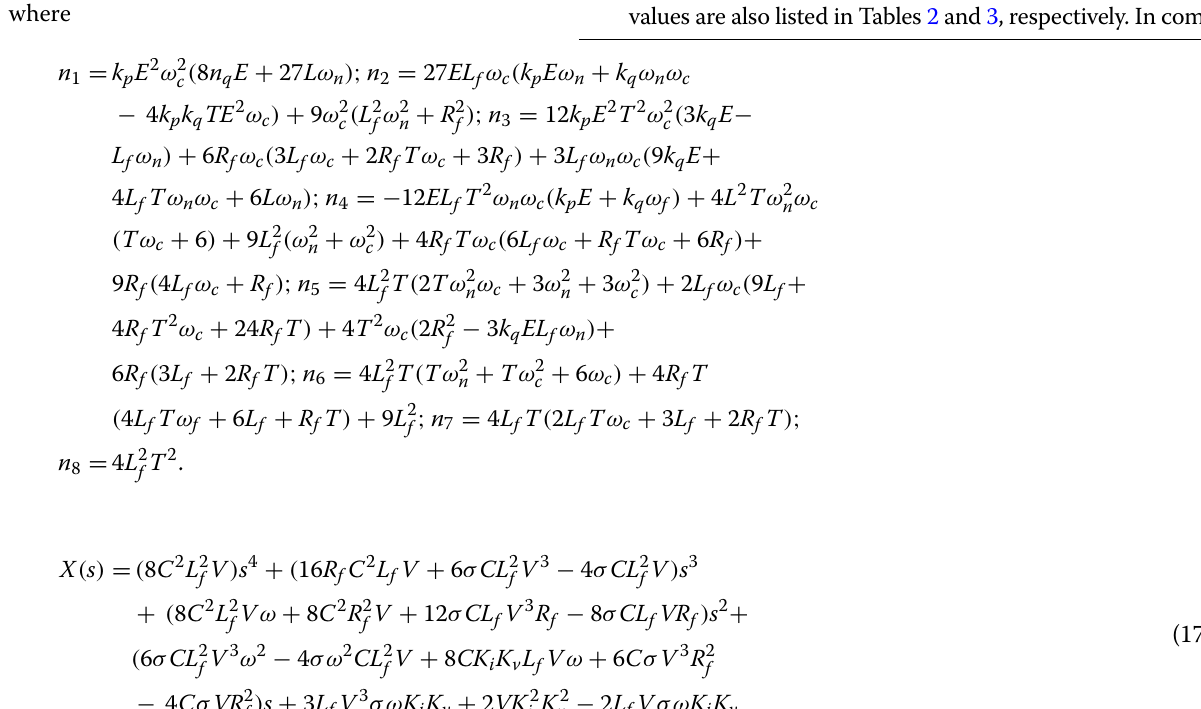
Figure 10i–iv display the eigenvalue plots of the system with different controllers, while changing the filter resist- ance. Similarly, Figs. 11i–iv shows the eigenvalue plots of the system while varying the filter inductance. Selected eigenvalues for different filter resistance and inductance values are also listed in Tables 2 and 3, respectively. In com-